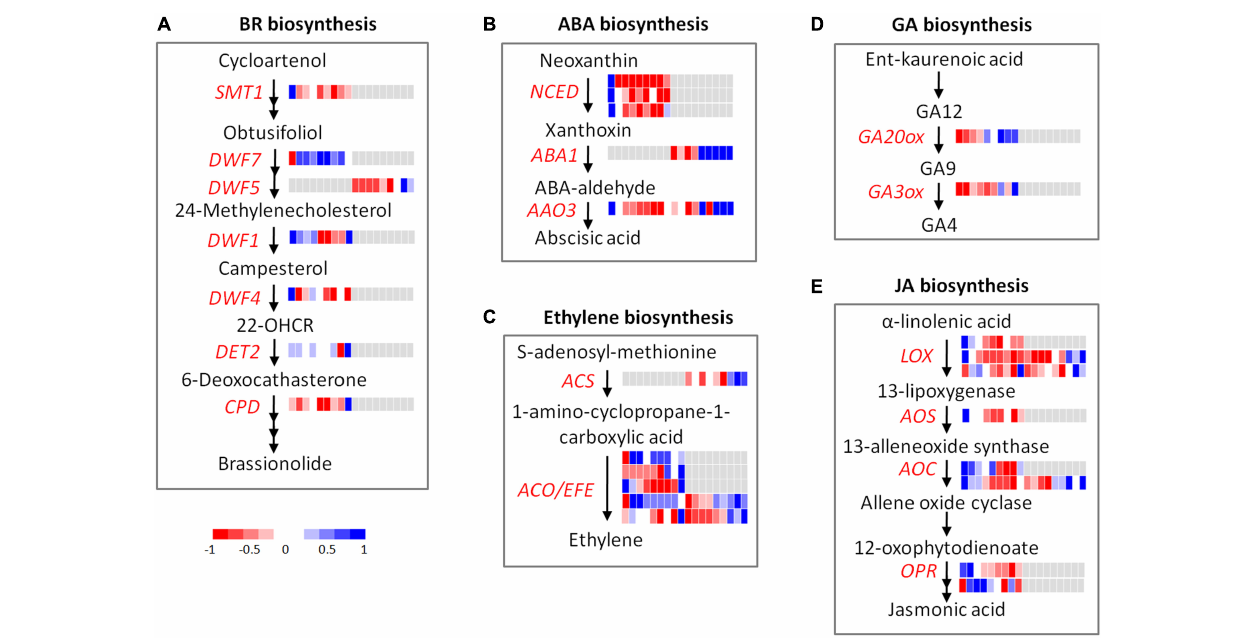
FIGURE 6 | Expression profiles of DEGs and DEPs involved in hormone metabolism during flooding stress. (A) BR biosynthesis, (B) ABA biosynthesis, (C) ethylene biosynthesis, (D) GA biosynthesis, (E) JA biosynthesis. Each row represents a gene, and the cells (from left to right) indicate the normalized expression value of R0, R6, R12, R18, R24, R30, R36, R48, and RR12 at the transcriptomic and proteomic levels, respectively.